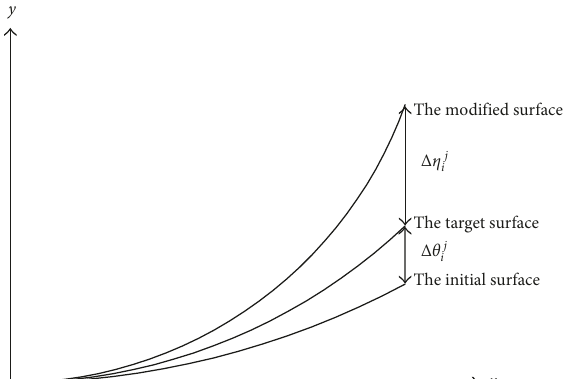
Figure 12: Schematic diagram before and after the adjustment along the x - y horizontal plane.